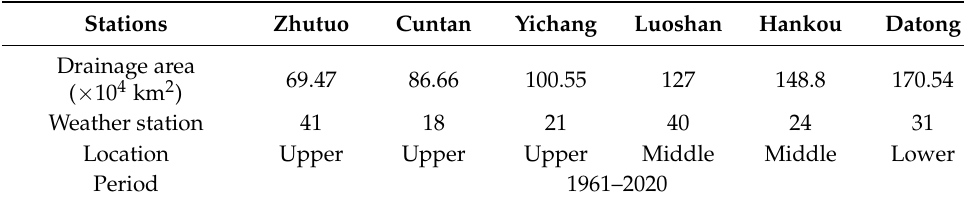
Table 1. Detailed data information of six hydrological